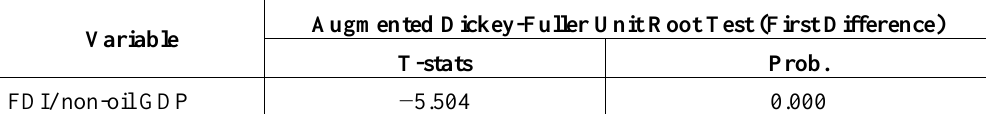
Table 2. Result of ADF Unit Root Test (first